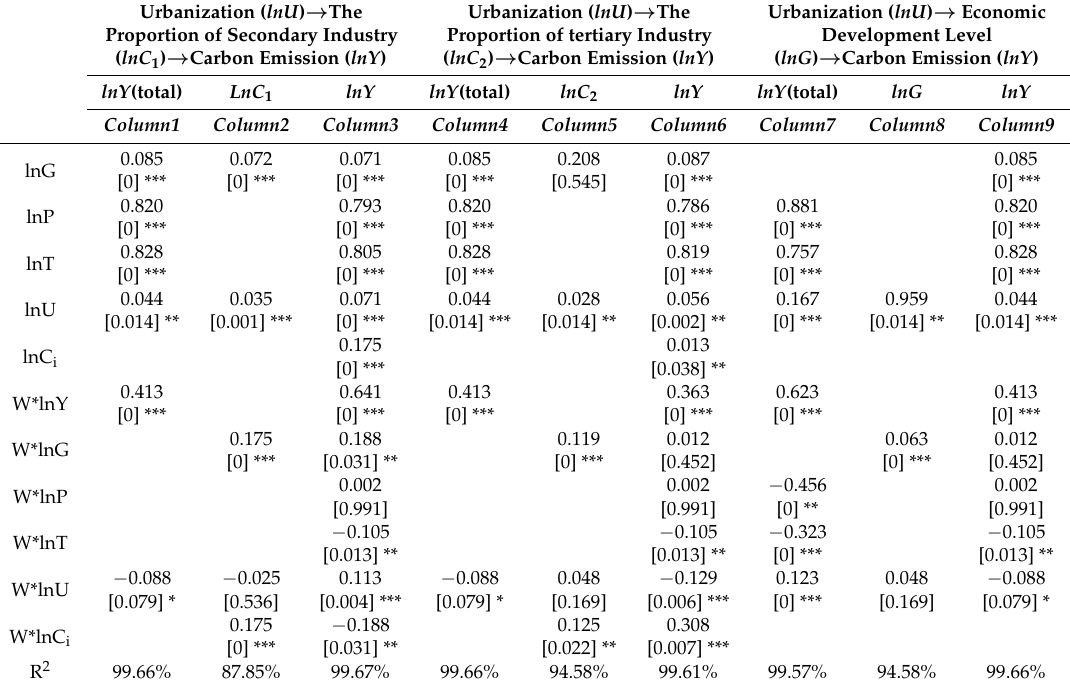
Table 6. Impact path test result of Urbanization → Mediating Variables → Carbon